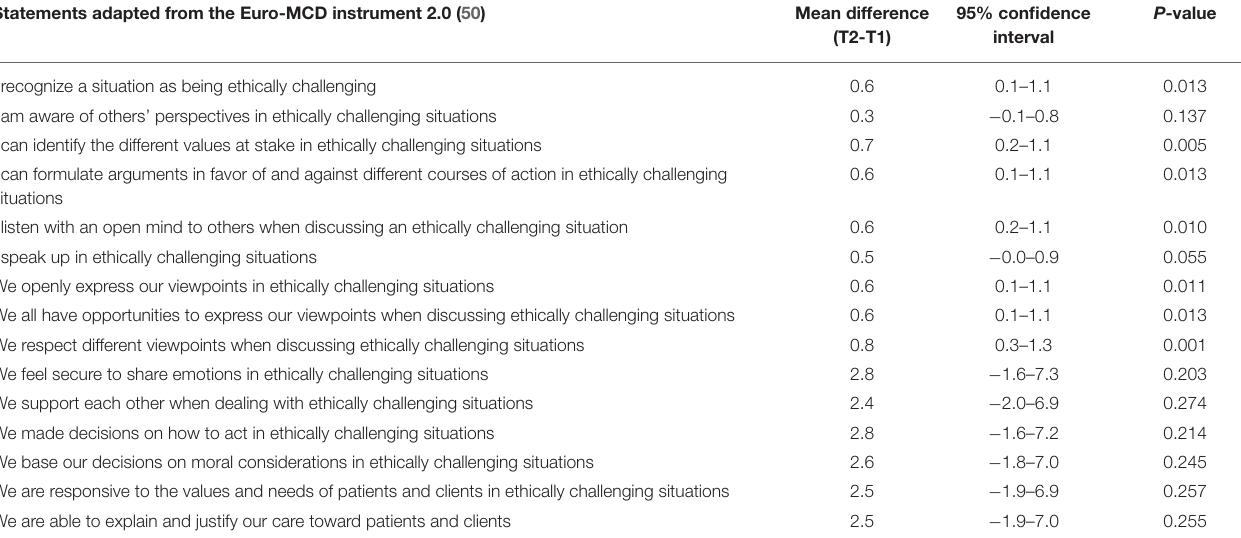
TABLE 6 | Mean difference between item-specific scores on Euro-MCD 2.0 from before and after participation in virtual ethics rounds ( n = 89). Statements adapted from the Euro-MCD instrument 2.0 (50) Mean difference